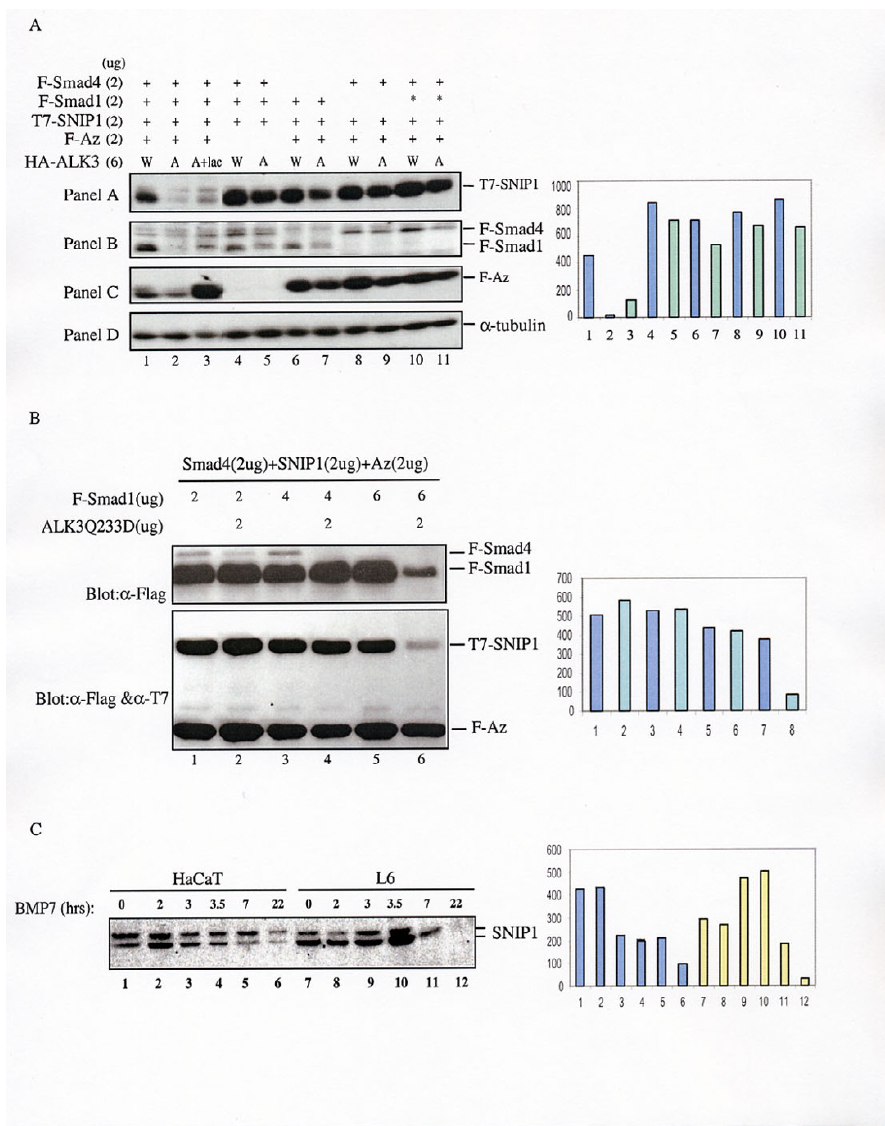
Figure 8 The activation of BMP type I receptor induces SNIP1 degradation which is co-regulated by Smad1, Smad4 and Az.A. SNIP1 degradation is lactacystin-sensitive and is dependent upon the co-expression of Smad1, Smad4 and Az in COS cell overexpression system. COS cells were transfected with the indicated plasmids. Lactacystin (10 µ M) was added during the last 10 hrs. The expression of each protein was detected by Western blot. Cell lysates were also blotted with a monoclonal anti- α tubulin, which served as a control for loading (bottom panel). "*" in lanes 10 and 11 represents the mutant Smad1 (G419S). This construct is T7 tagged, thus did not show on the anti-Flag blot (top panel). Its expression was confirmed by anti- T7 on a separate blot (not shown). The right panel shows the Integrated Optical Density of SNIP1 obtained from quantification of SNIP1 signals using Densitometry. B. Increased expression of Smad1 enhances SNIP1 degradation induced by BMP type I receptor activation. COS1 cells were transfected with the indicated amount of DNA constructs of Smad1, Smad4, SNIP1, Az and ALK3Q233D. The protein levels were detected by Western blot. The IOD of SNIP1 is plotted in the right panel. For both panels, equal transfection efficiency was monitored by GFP and equal total protein loading was assured after protein concen- tration measurement. C. The degradation of endogenous SNIP1 is induced in a time-dependent fashion by BMP7 in HaCaT and L6 cells. HaCaT and L6 cells were treated with BMP7 (250 ng/ml) for the indicated time periods and cell lysates were separated on SDS-PAGE then blotted by anti-SNIP1 polyclonal antibody [25]. Two different forms of endogenous SNIP1 are indicated as SNIP1.A and SNIP1.B. The IOD of the combined IOD of these two forms are plotted in the right